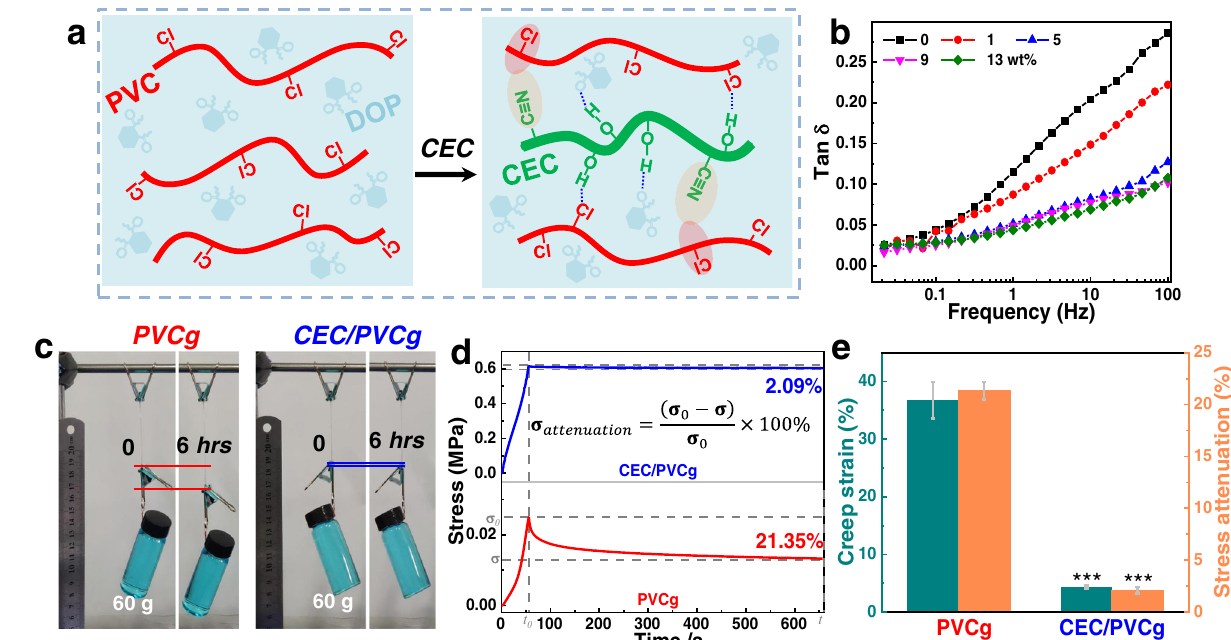
Fig.4|DynamicandstaticviscoelasticityofCEC/PVCgelastomers.a Schematic illumination of the multiple molecular interactions between CEC (green) and PVC (red), which contribute to the reduced viscoelasticity of CEC/PVCg elastomers. b Mechanical losses (tan δ = G ” /G ’ ) of CEC/PVCg elastomers with 0, 1, 5, 9, 13wt% loadingconcentrationsofCECunderfrequenciesof0.01 – 100Hz. c Creep-induced strainsofPVCgandCEC/PVCgelastomersundera fi xedloadof60gfor6h. d Stress